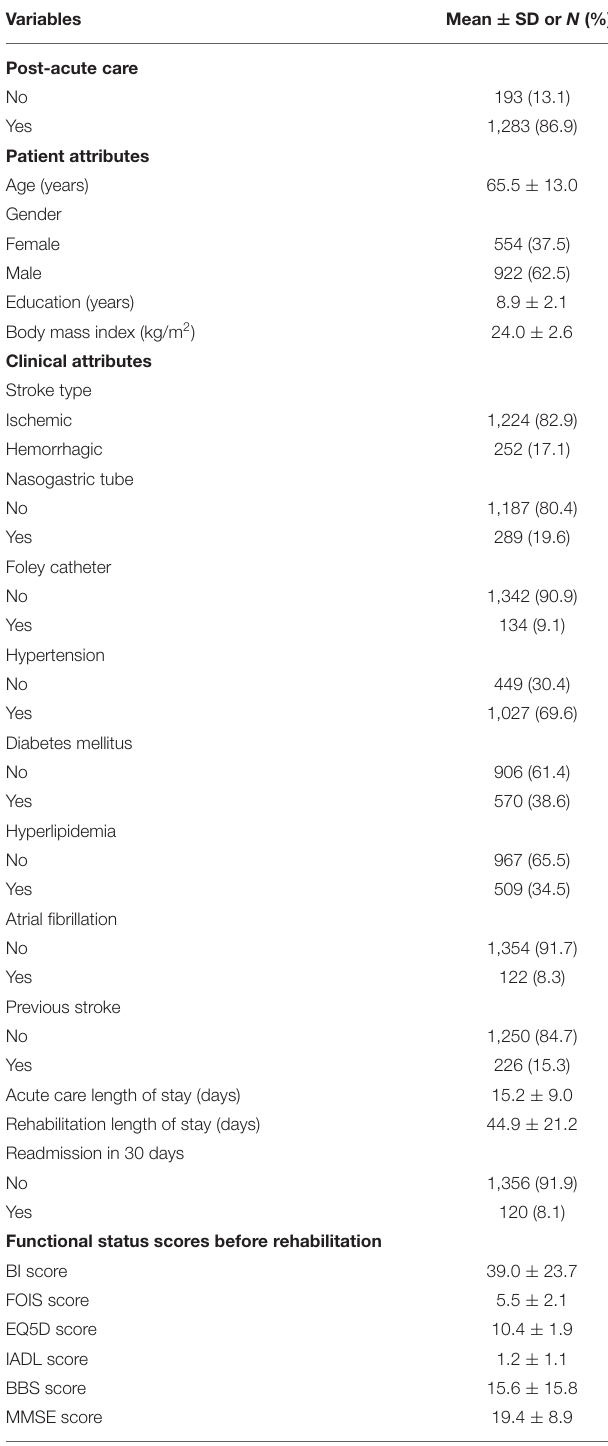
TABLE 2 | Baseline characteristics of the study population ( N =